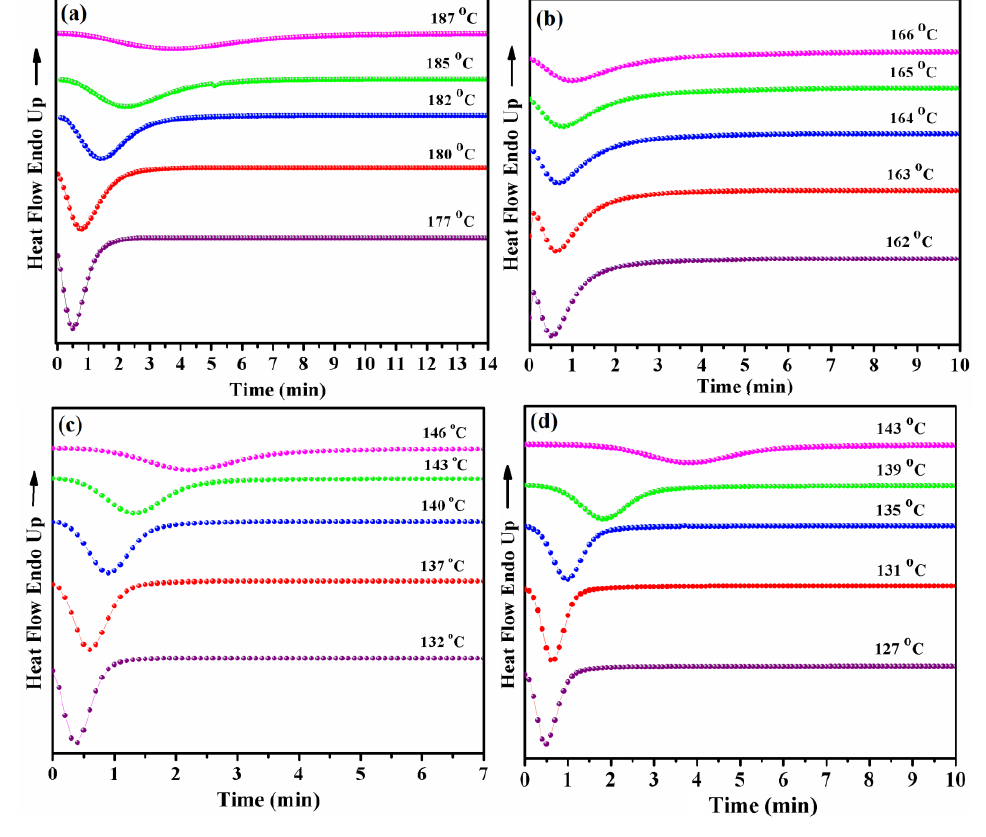
Figure 6. DSC thermograms of isothermal crystallization of ( a ) virgin PA6, ( b ) PA6-BABA/SA 30 , ( c ) PA6-BABA/SA 50 , and ( d ) PA6-BABA/SA 70 at various T iso .